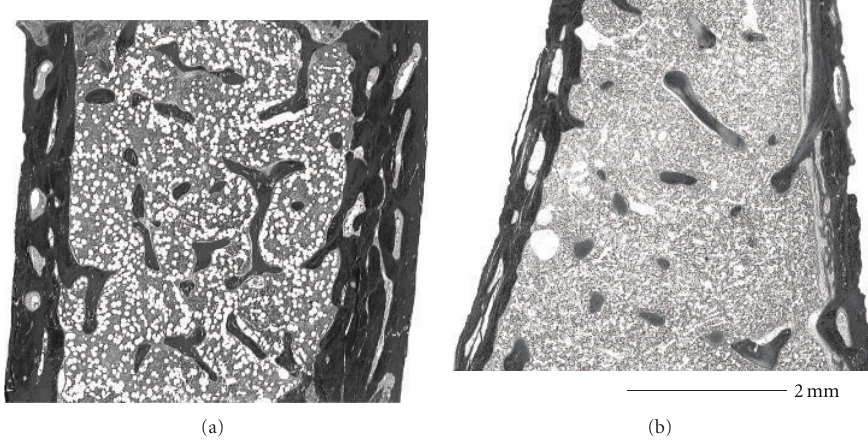
Figure 5: Representative examples of iliac bone samples. ( a ) Haploinsu ffi ciency mutation, in a 4-year-old boy with a c.1981C > T nucleotide change in COL1A1 that creates a stop codon (p.Gln661X). Core width 4.8mm, cortical width 765 μ m, bone volume per tissue